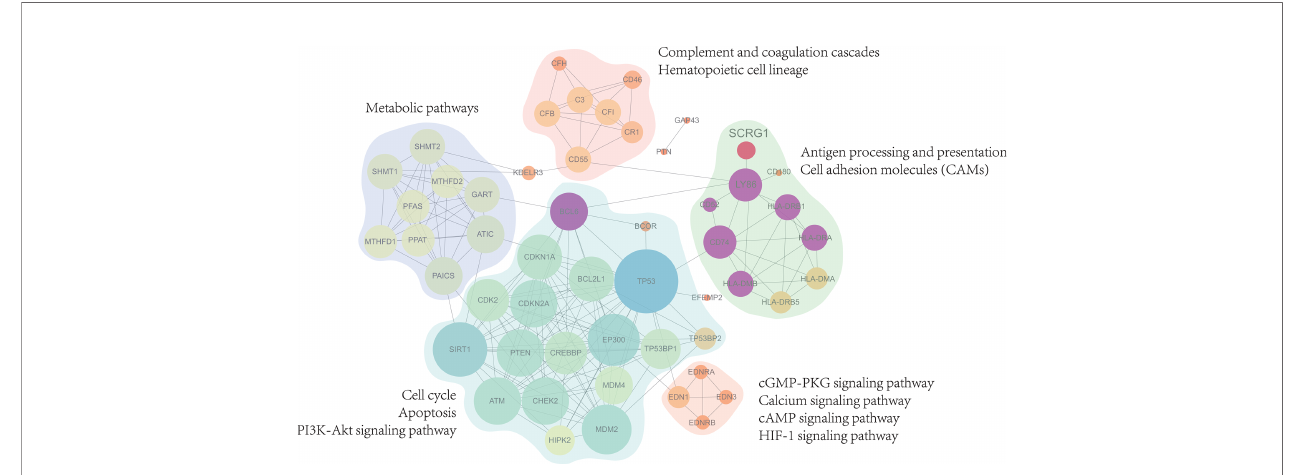
FIGURE 4 | Protein-Protein interactions analysis with 27 genes associated expression with SCRG1. The PPI network showed 5 sub-functional clusters were identi fi ed and suggest that SCRG1 may be a protein complexes service with important biological function in OA. And the biological function is mainly related to metabolic pathways, complement and coagulation cascades, Antigen processing and presentation, Apoptosis, and immune-related signaling